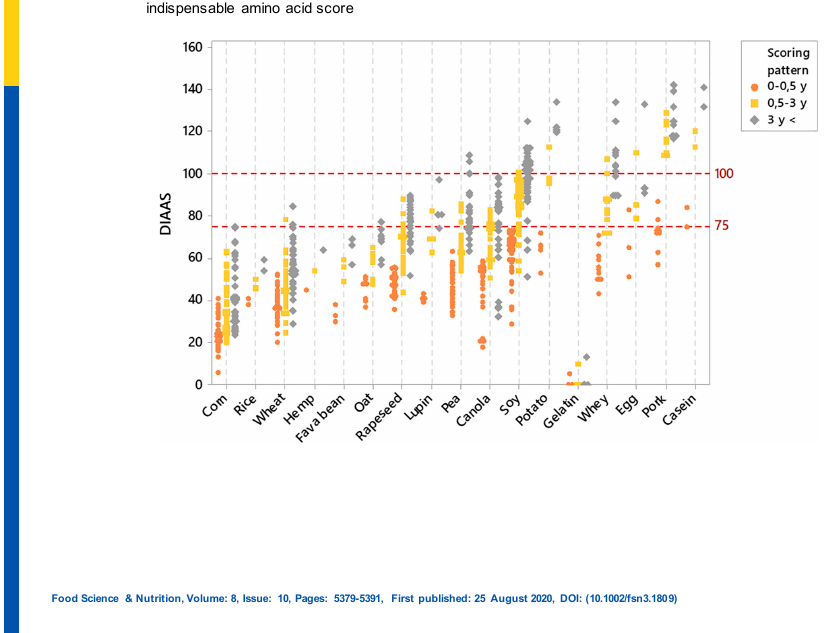
Figure 1. Overview of the quality of individual proteins based on their digestible indispensable amino acid score (DIAAS) [16].